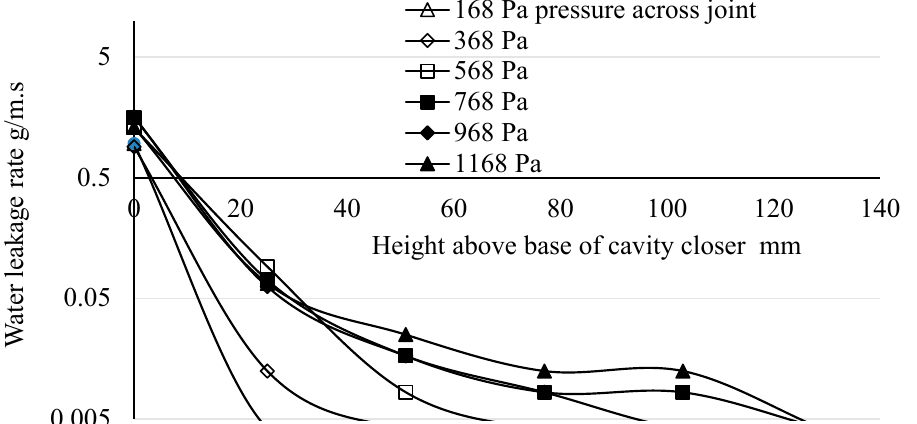
Figure 17. Mass flow of water reaching various heights above the base of the cavity closer of an apron